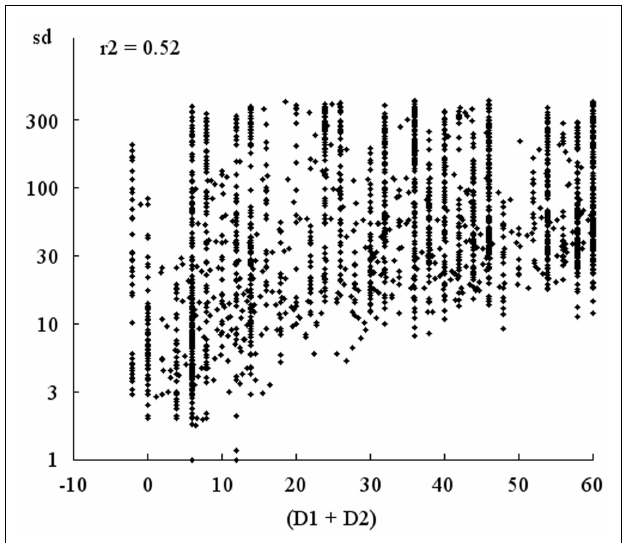
FIGURE 10 | Correlation between the width of the attractor “SD” and ( D 1 + D 2). “SD” is the standard deviation of the distance of the perceptual field from the center of the point of stimulation, i.e., the body-object of the other subject. As the disequilibrium ( D 1 + D 2) decreases over time, “SD” also decreases, i.e., the attractor shown in Figure 4 becomes narrower.The correlation coefficient of 0.52 is highly significant.